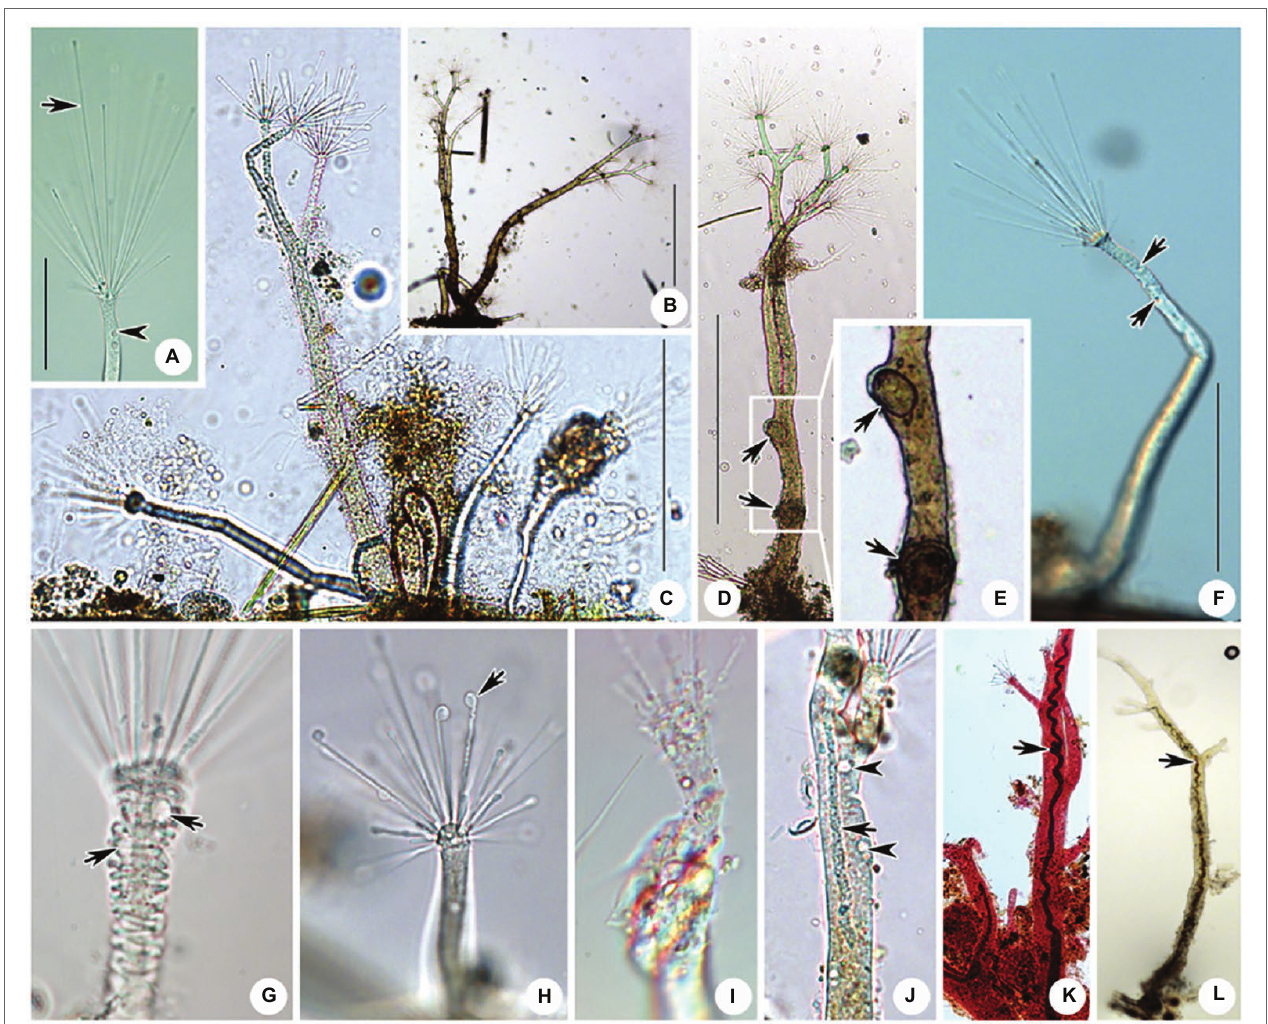
FIGURE 8 | Photomicrographs of D. radians Ehrenberg, 1838 from life (A–J) and after protargol staining (L) as well as Methyl Green-Pyronin Staining (K) . (A) Part of branch, arrow to show the fully stretched tentacle, arrowhead to show contractile vacuole. (B–D,F) View of different individuals in different periods of life history. (E) Same individual as (D) enlarged to show the swarmers (arrows). Arrows in (D,E) to show the swarmers. Arrows in (F) to show contractile vacuoles. (G) Part of branch, to show some ends of branches can shrink. Arrows to show contractile vacuoles. (H) Arrow to show the spherical end of shrink tentacle. (I) Under unfavorable conditions tentacles and tentacle actinophores can be melted. (J) Arrow to show the filiform macronucleus, which traverses the whole cell. Arrowheads show the contractile vacuoles. (K) After Methyl Green-Pyronin Staining, arrow to show the filiform macronucleus. (L) After protargol staining, arrow to show the filiform macronucleus. Scale bars = 50 μ m (A), = 500 μ m (B–D,F)